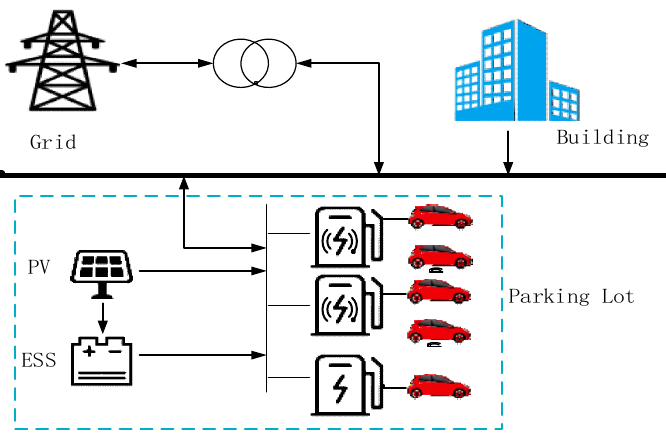
Figure 1. The structure of parking lot energy management system.